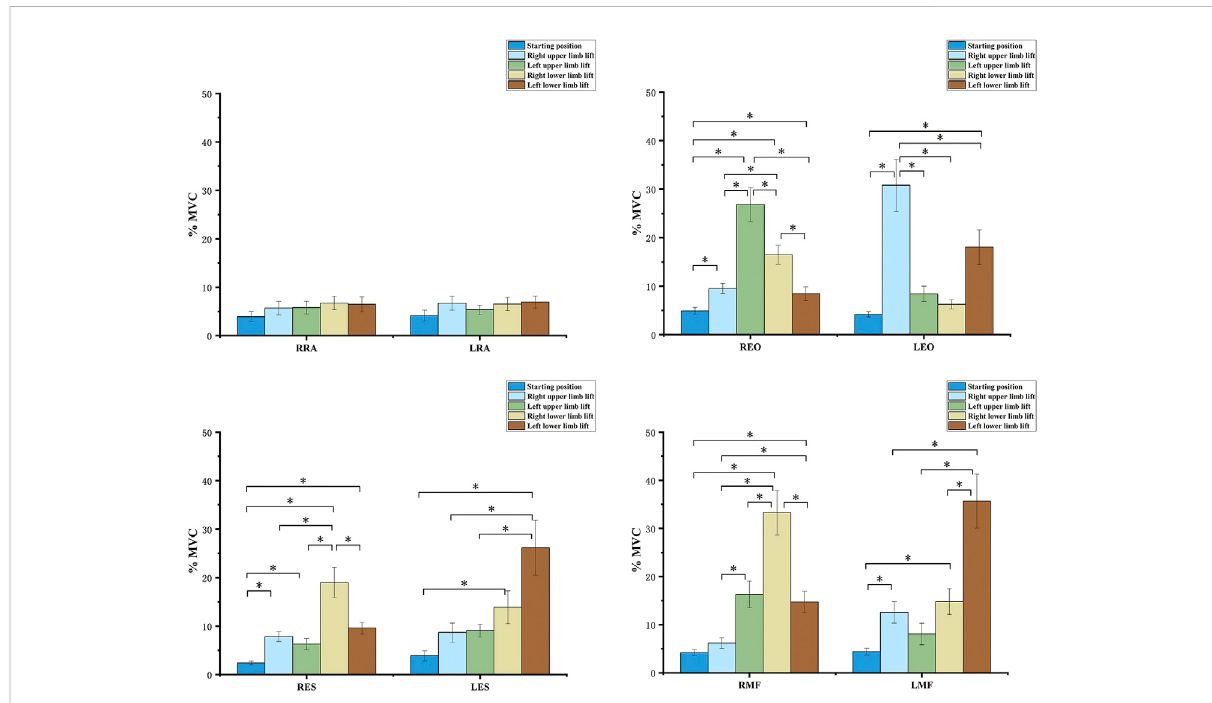
FIGURE 4 sEMG values and results of one-way ANOVA during the four-point hand − knee kneeling positions, respectively. The negative value meant the vertebra rotates to the left, and the positive value meant the vertebra rotates to the right; RRA, right rectus abdominis; LRA, left rectus abdominis; REO, right external oblique; LEO, left external oblique; RES, right erector spinae; LES, left erector spinae; RMF, right lumbar multi fi dus; LMF, left lumbar multi fi dus. *: statistically signi fi cant, p <